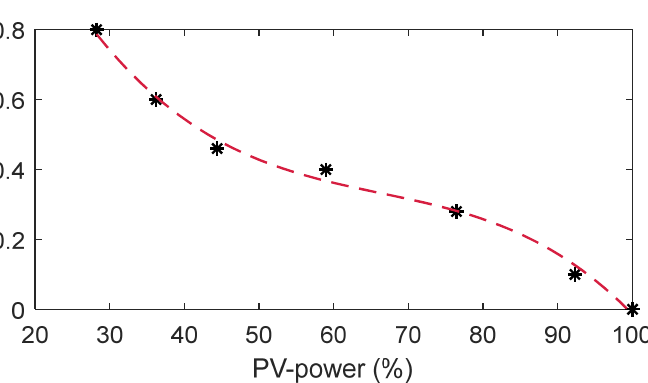
Figure 7. The flowchart of the expert artificial intelligence system.